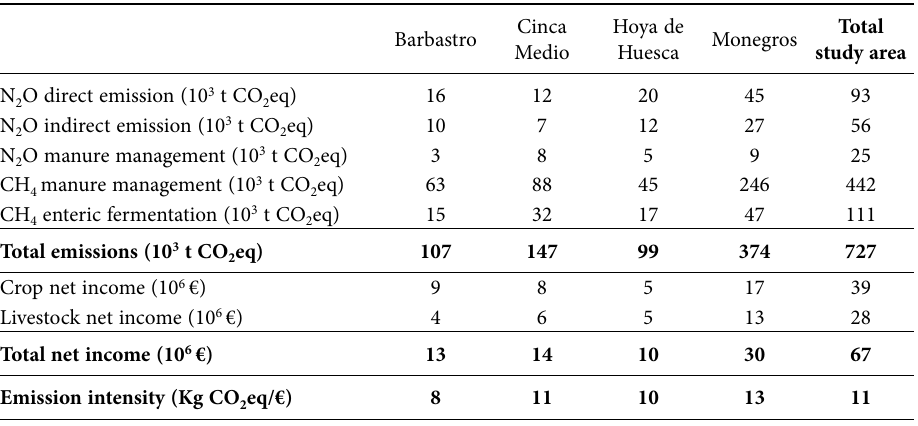
Table 2. GHG emissions and farmers’ net income from agricultural production activities.